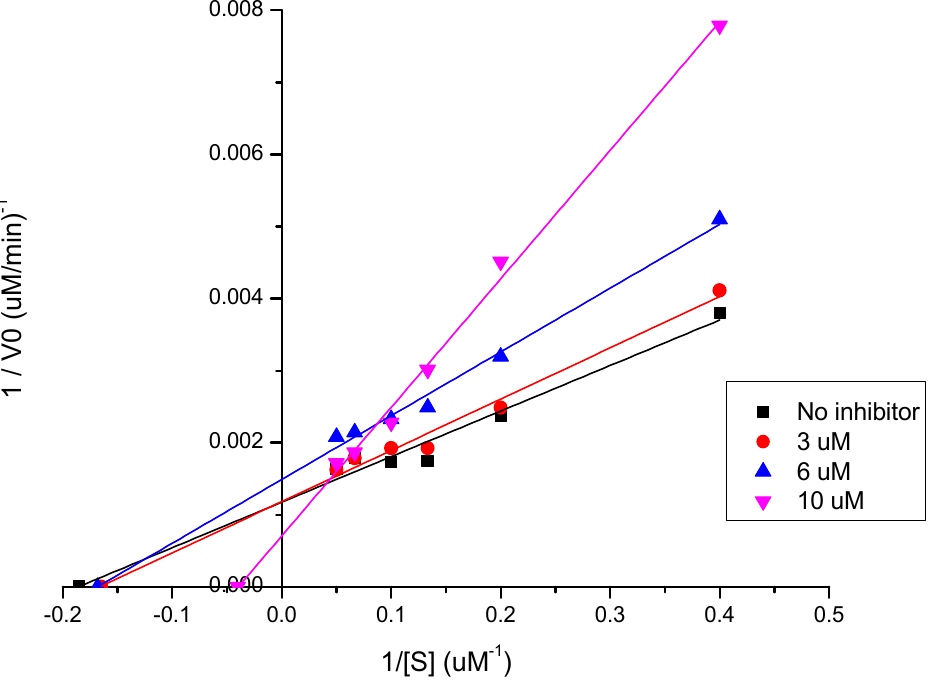
Figure 5. Double reciprocal Lineweaver-Burk plot showing the relationship between the reciprocal of the enzyme activity (1/V 0 ) and the reciprocal of the substrate concentration (1/[S]). The intercept of the plot with the abscissa gives the reciprocal of the Michaelis-Menten constant (l/K m ) in the absence ( w / o ) and in the presence of 3, 6, and 10 µM of LQOF-G6 . Although other natural and synthetic CPB inhibitors have been reported [20], none of them have been preclinically followed up on in cutaneous leishmaniasis models. It is worth mentioning the selectivity of LQOF-G6 , which did not inhibit human cathepsins B and L at concentrations ranging from 2 to 10 µM (SI Section). These results suggest that LQOF-G6 can be proposed for more advanced studies as a candidate for therapeutic agents against L. amazonensis infections. The enzymatic inhibition of human isoforms of cathepsin L and cathepsin B was essayed by Eurofins. LQOF-G6 was tested at 1 µM and 10 µM concentrations, and no significant inhibition (>50%) was observed for either of the tested concentrations. The whole report can be found in the supporting information section. The novel LQOF-G32 molecule was also tested as a CPB inhibitor and showed 53% of inhibition at the test concentration of 20 µM, which is somewhat lower compared to LQOF-G6 . With the promising data of enzymatic inhibition of LQOF-G6 in hand, leishmanicidal activity was still tested to complement the work.